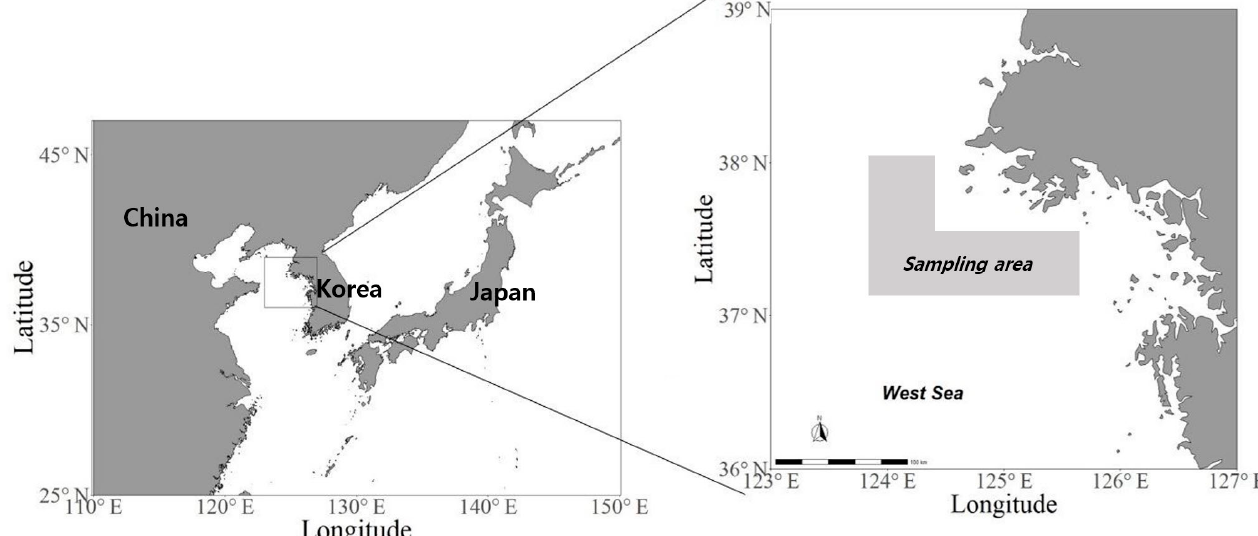
Figure 1. Location of the ocellate spot skate ( Okamejei kenojei ) sampling area in this study.